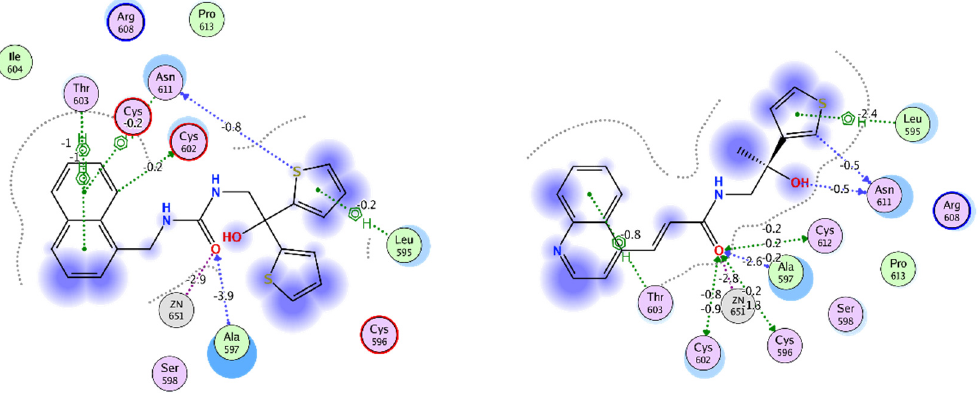
Figure 5. Ligand–protein interactions of VPC-17160 ( left ) and VPC-17281 ( right ). Residues in green—hydrophobic, in purple—polar. Numbers next to bonds indicate estimated bond energy in kcal/mol.